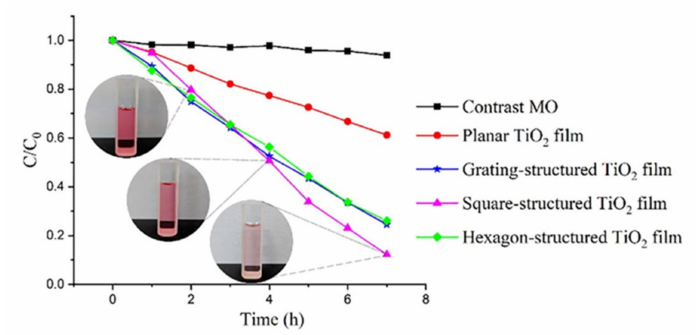
Figure 9. Photocatalytic degradation of MO under ultraviolet light (254 nm) irradiation. C and C 0 represent the real-time and initial concentration of methyl orange solution. This figure is reprinted from [89], with permission from Elsevier,